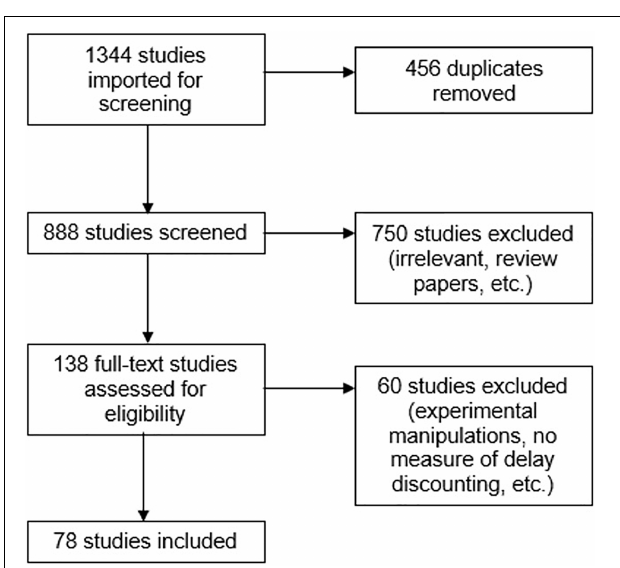
FIGURE 1 | PRISMA